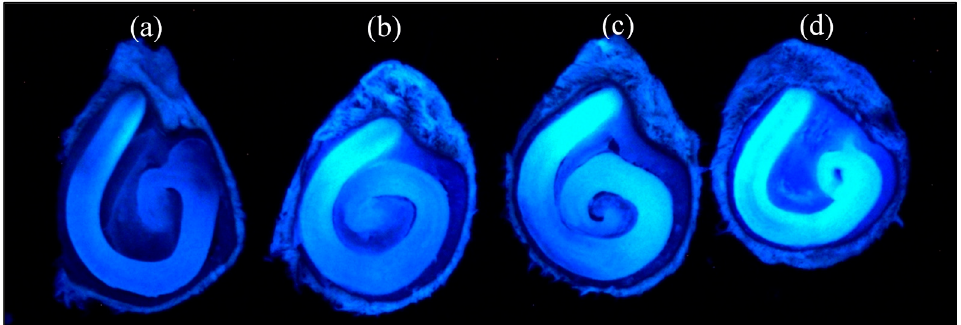
Figure 2. Tomato “Hypeel 696” seed coat permeability of three different coumarin tracers: ( a ) non- treated, ( b ) coumarin 1, ( c ) coumarin 151, and ( d ) coumarin 120. treated, ( b ) coumarin 1, ( c ) coumarin 151, and ( d ) coumarin